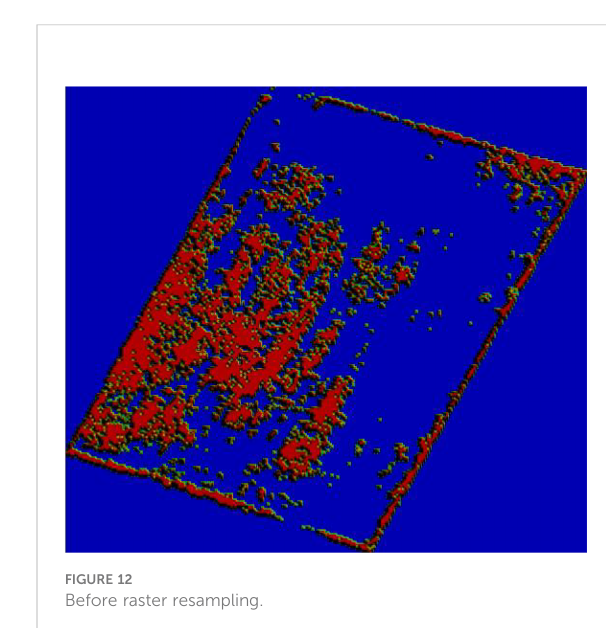
FIGURE 11 The result after clustering process.